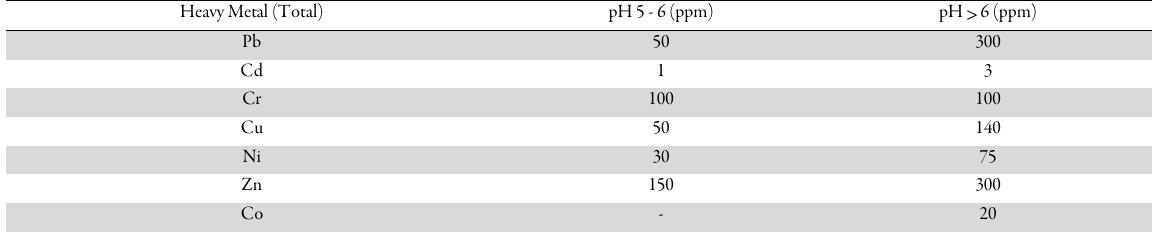
Table 4. Heavy metal limit values in the ground (Moen et al ., 1986)